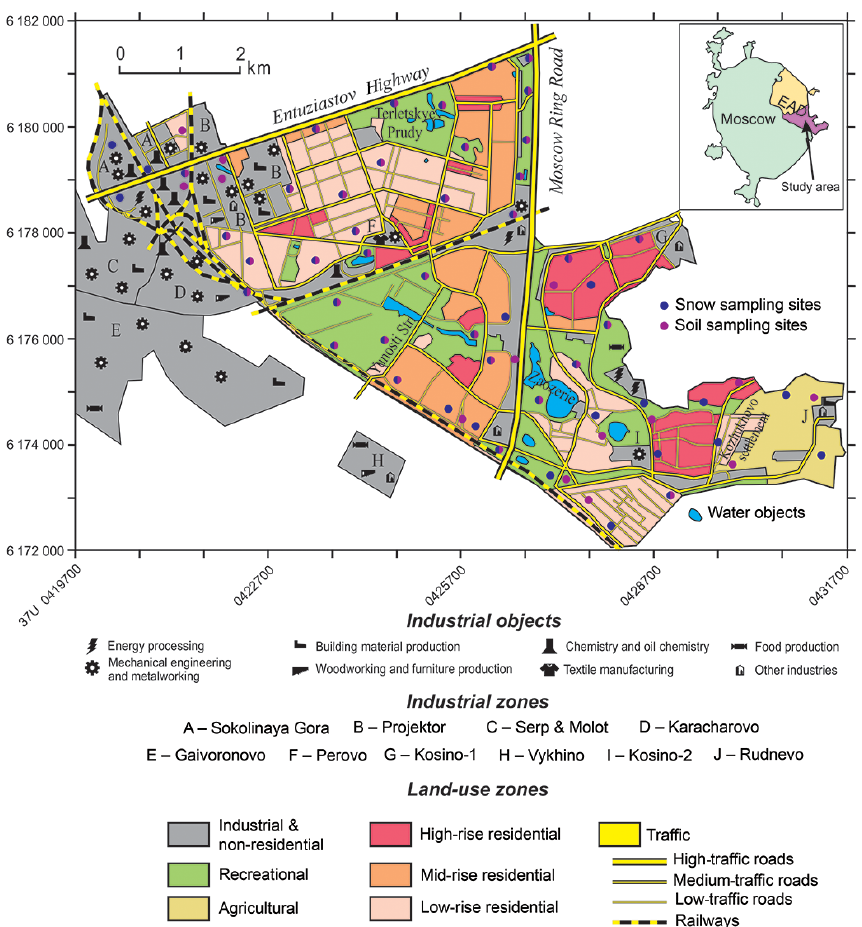
Figure 1. Land-use zoning of the study area with main sources of BaP and locations of the sampling points; the UTM coordinate